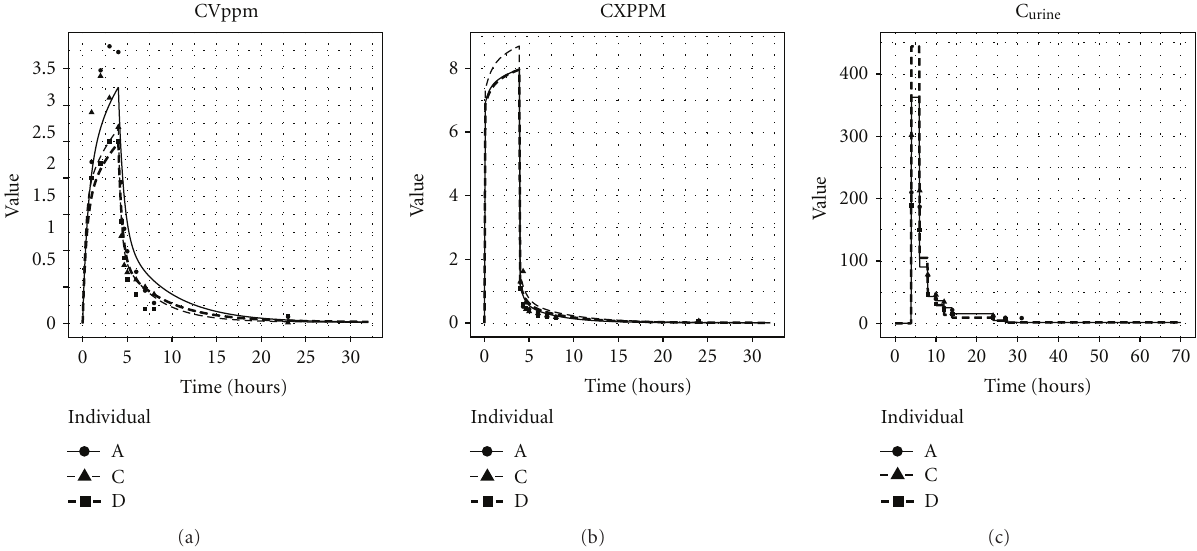
Figure 10: Model predictions for three volunteers from one iteration of the Markov chain and the associated measurements: (a) urine predictions and data, (b) CV predictions and data, (c) CX predictions and